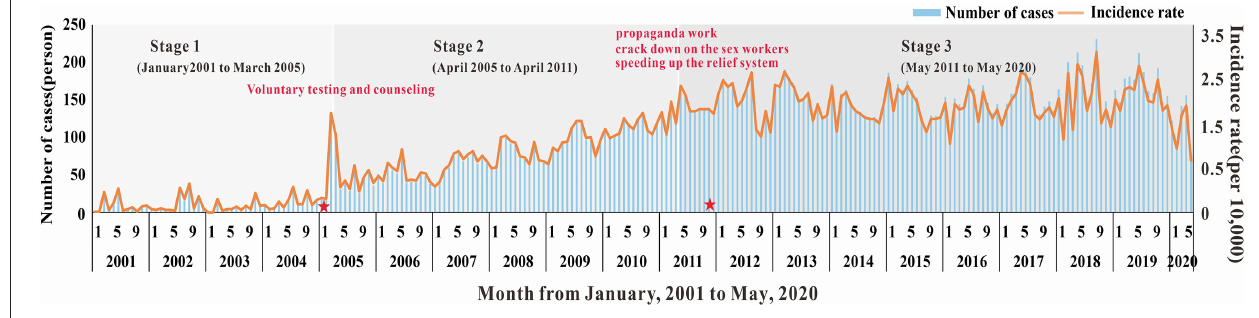
FIGURE 2 | The number of cases and incidence rate of HIV in Nanning from 2001 to 2020.